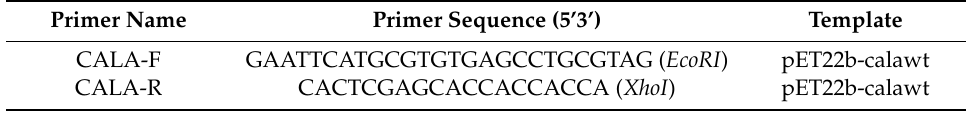
Table 5. Primers used in this study.